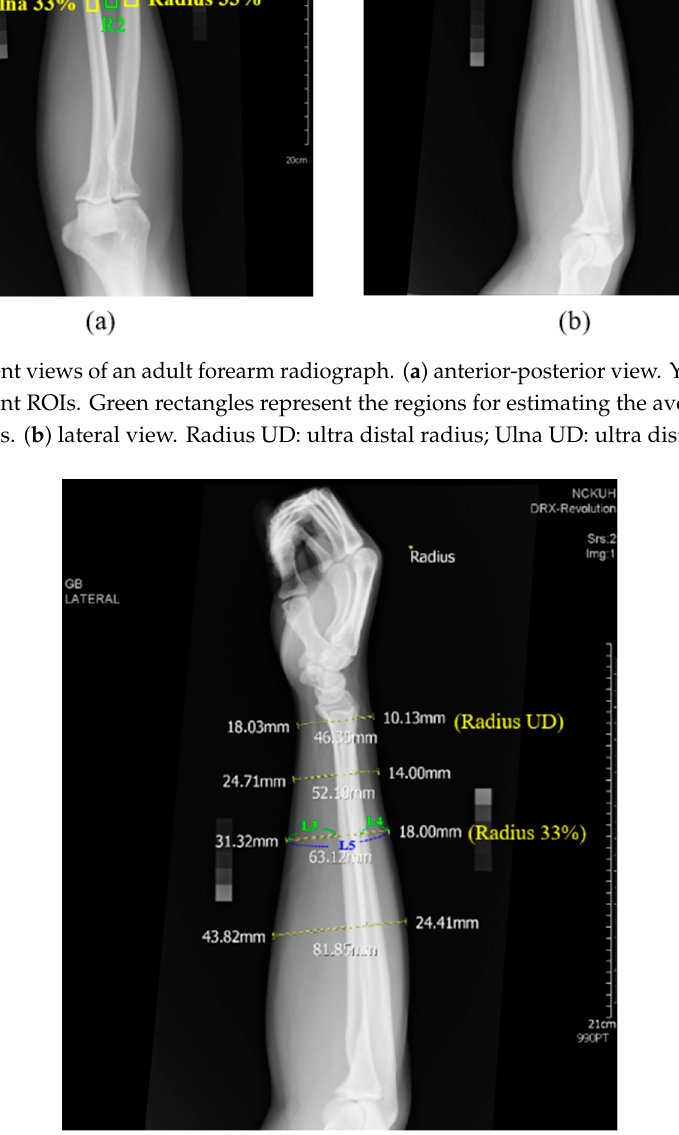
Figure 10. Materials for calculating the adjustment parameter S. For example, the parameter S for the ROI of Radius 33% is calculated by (L3 + L4)/L5, where these yellow dashed segments are drawn by an expert and the length of these segments are automatically calculated by the computer program. Radius UD: ultra distal radius.